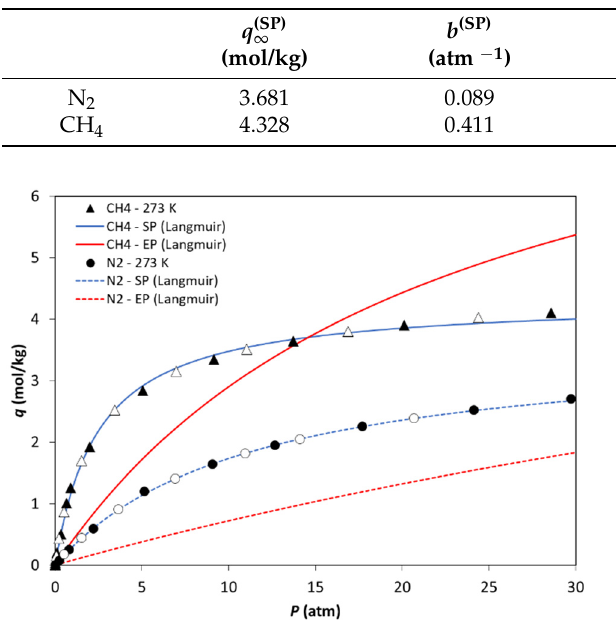
Figure 9. Fitting of the Langmuir isotherm model to the CH 4 ( ▲ ) and N 2 ( ● ) experimental adsorption equilibrium isotherms at 273 K. Filled and empty symbols denote experimental adsorption and desorption data, respectively. Solid lines: fitted CH 4 Langmuir isotherm for rigid framework constrained to its EP (red) and SP (blue) forms; dashed lines: fitted N 2 Langmuir isotherm for rigid framework constrained to its EP (red) and SP (blue) forms. Table 2. Fitting of the Langmuir adsorption isotherm model to the CH 4 and N 2 experimental ad- sorption data at 273 K. The parameters for the EP form are estimated as 𝑞 (cid:3036),(cid:2998)(EP) = 𝑞 (cid:3036),(cid:2998)(SP) 𝑞 (EP) /𝑏 (SP) . and 𝑏 (cid:3036)(EP) = 𝑏 (cid:3036)(SP) 𝑏 CO (cid:3118) CO (cid:3118)